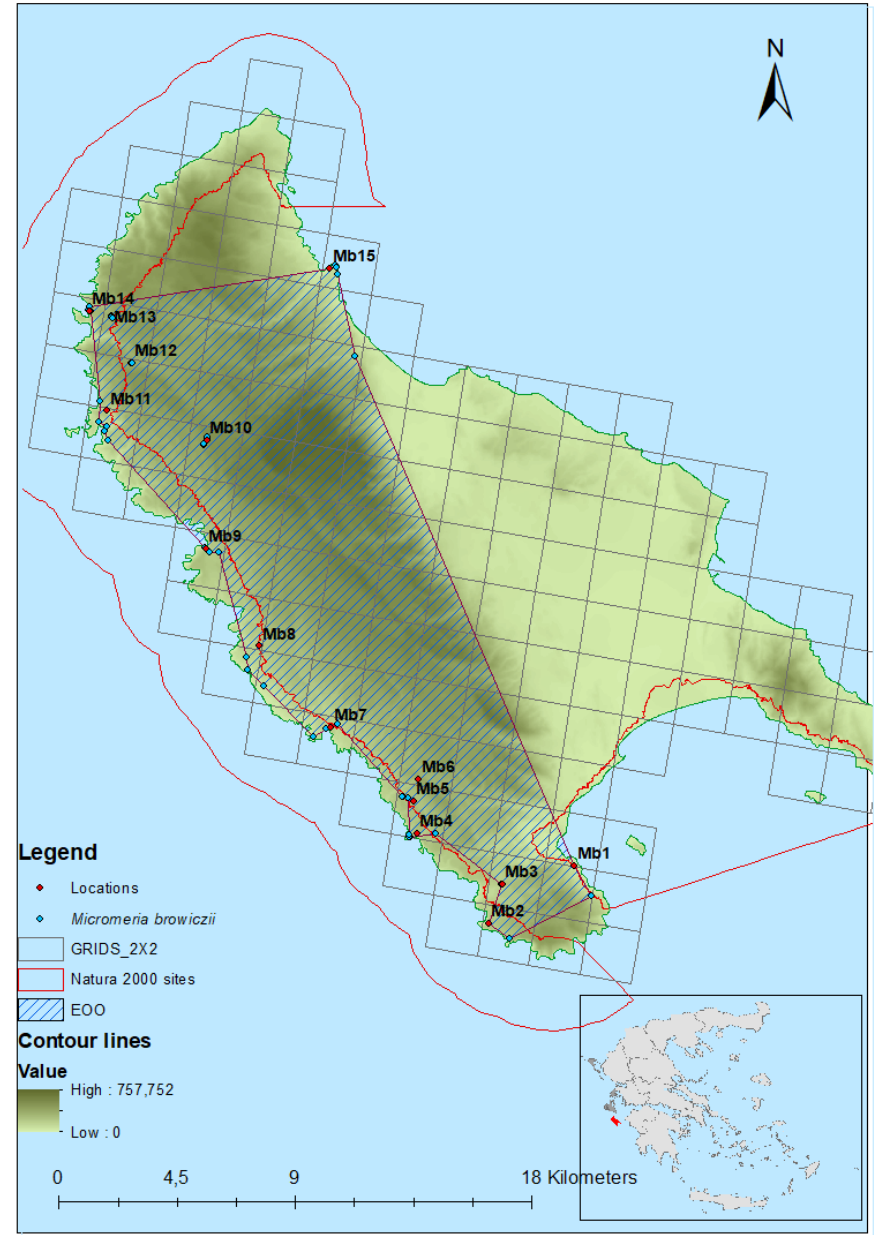
Figure 1. Geographical distribution of Micromeria browiczii subpopulations (blue dots) on Zakynthos Island, the estimated extent of occurrence (EOO), and area of occupancy (AOO) based on 2 × 2 km 2 grid. Table 2. Number of mature individuals (subpopulation size), local extent (the minimum area polygon or polygons includ- ing all the plant colonies not separated by unsuitable habitat at each location) and plants per m 2 for each subpopulation per year. Subpopulation abbreviations as in Table 1. SP: subpopulation.